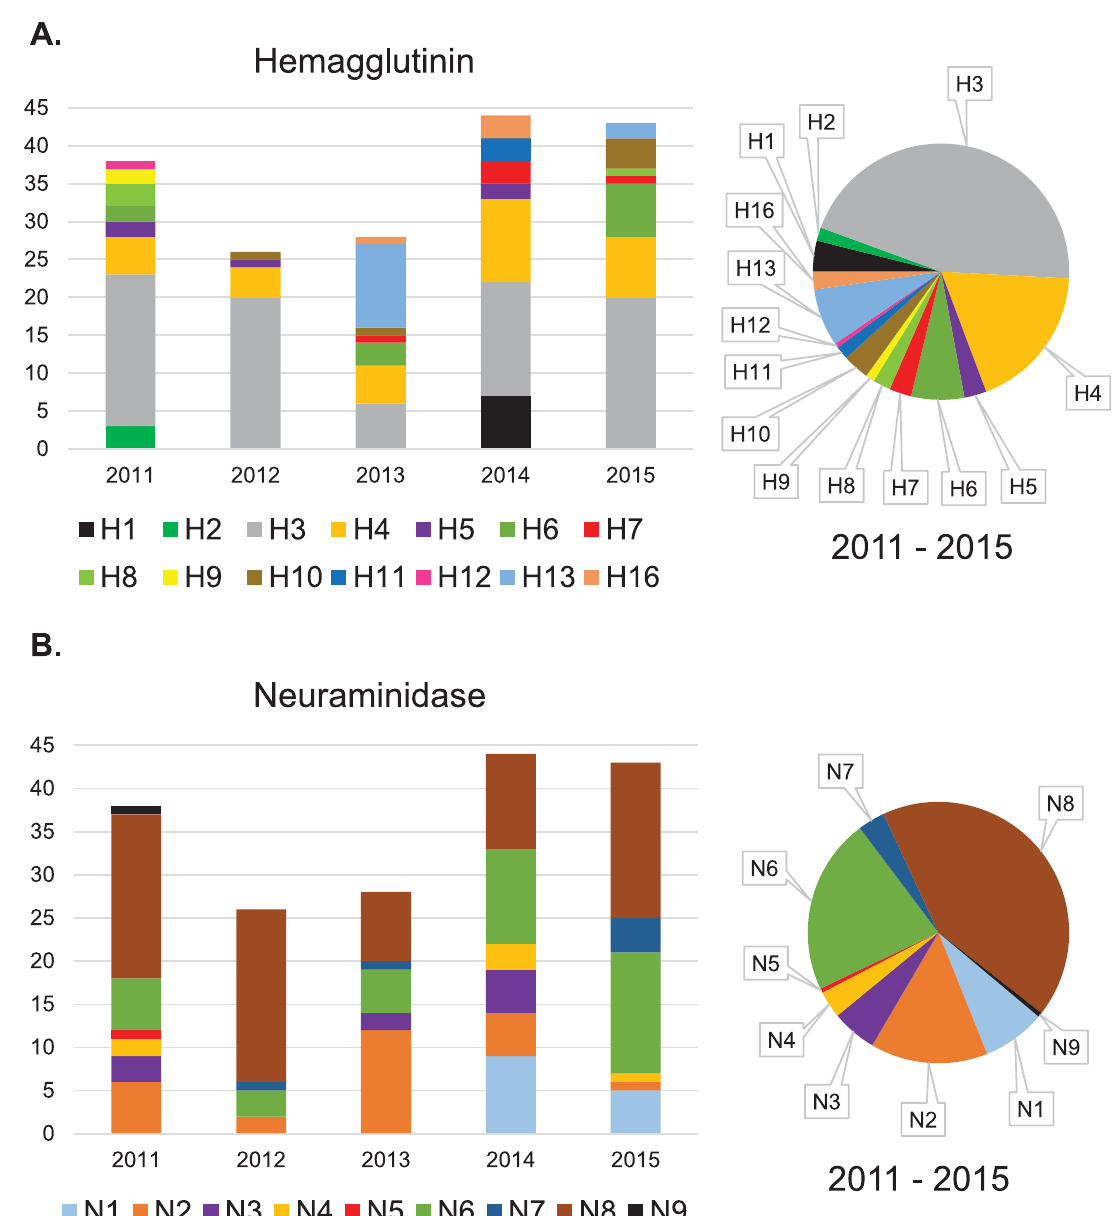
Fig 2. Hemagglutinin and Neuraminidase subtypes identified by year. Totals and proportions of influenza A virus subtypes (Hemagglutinin [HA, A]; Neuraminidase [NA, B]) identified per year from virus isolation positive samples collected at Izembek National Wildlife Refuge, Alaska, USA. The number of sequences identified for each of the surface glycoproteins are 38, 26, 28, 44, and 43 for the years 2011–2015, respectively. The total numbers of HA and NA sequences (179 each) exceed the total number of isolates genomically sequenced (172) because two HA and two NA sequences were identified from seven mixed infection